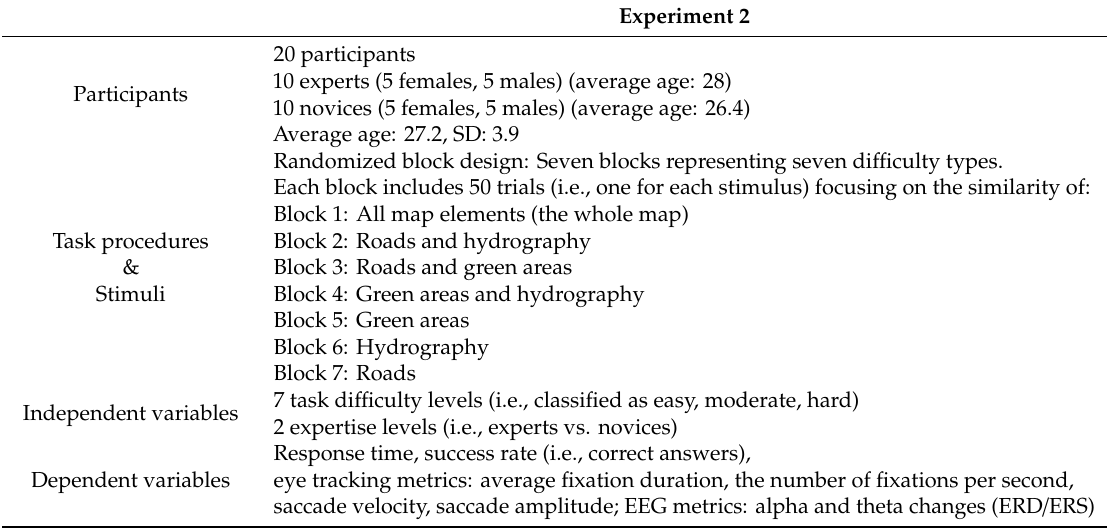
Table 1. Experimental design elements (modified from